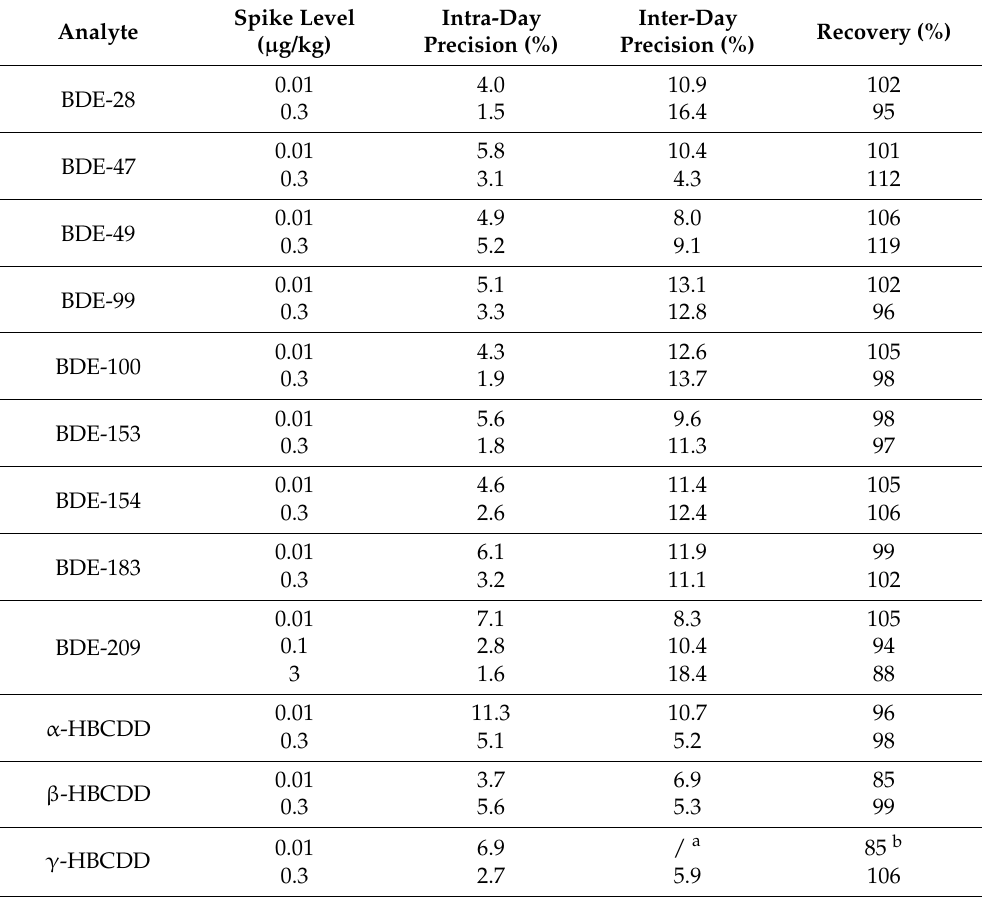
Table 3. Intra-day ( n = 6), inter-day precision ( n = 12), and average recoveries ( n = 12) of fortified infant milk